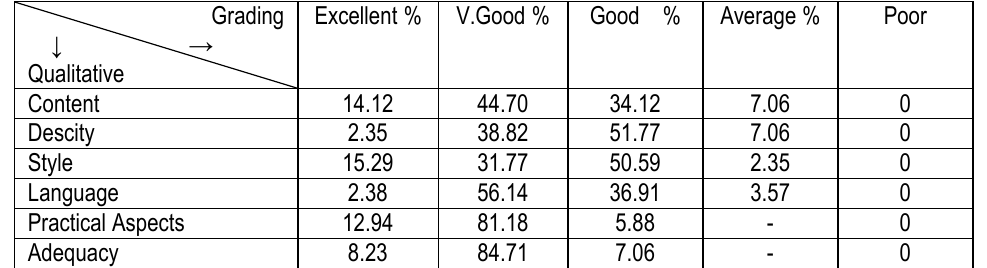
Table 1. Response of Academics on Qualitative Aspect